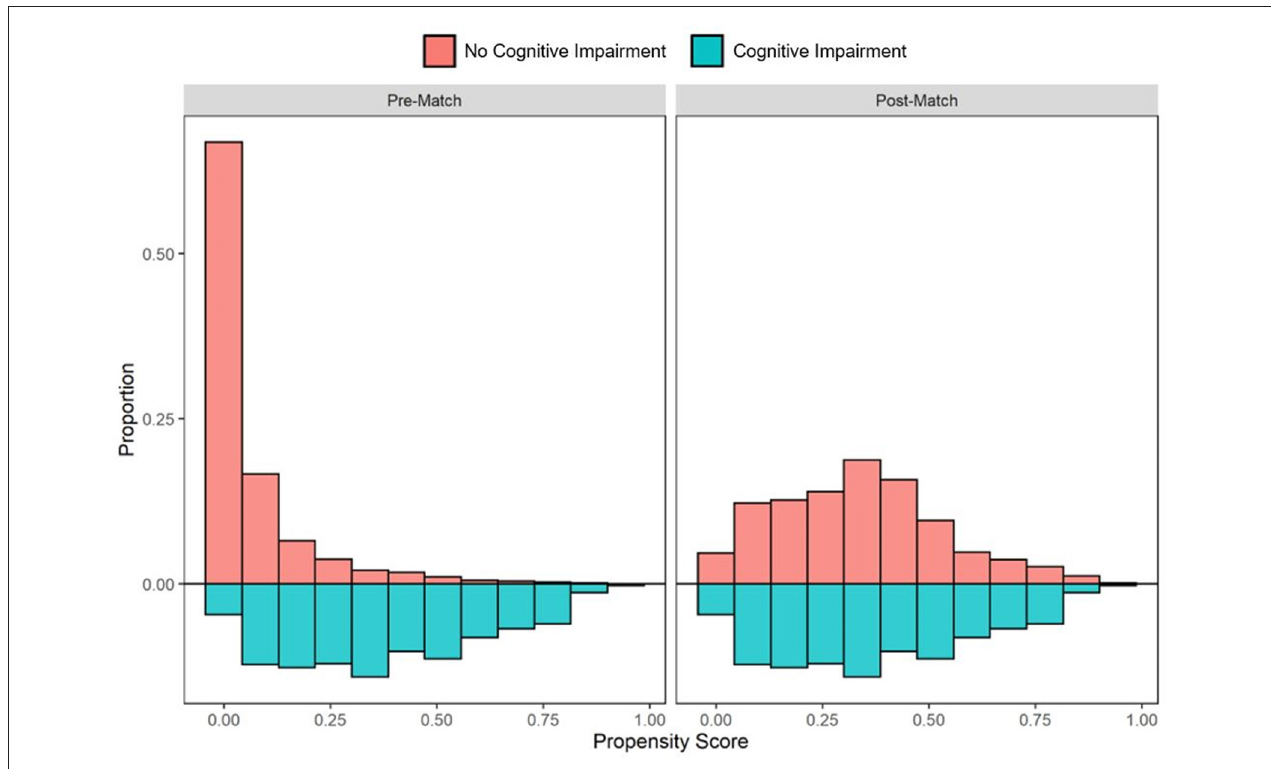
FIGURE 5 | Pre- and post-matched distribution of individual propensity scores among COVID-19 hospitalized patients, by preexisting cognitive impairment status. Cohort proportions ( Y -axis) by propensity score ( X -axis) are presented. Cohorts matched on age, sex, race, ethnicity, marital status, insurance coverage, area deprivation index (ADI), obesity, diabetes, hypertension, overall Charlson Comorbidity Index (CCI), mean systolic and diastolic blood pressure (SBP/DBP) at admission, elevated respiratory rate at admission, elevated temperature at admission, low oxygen saturation (O2) at admission, intensive care unit (ICU) stay, and mechanical ventilation